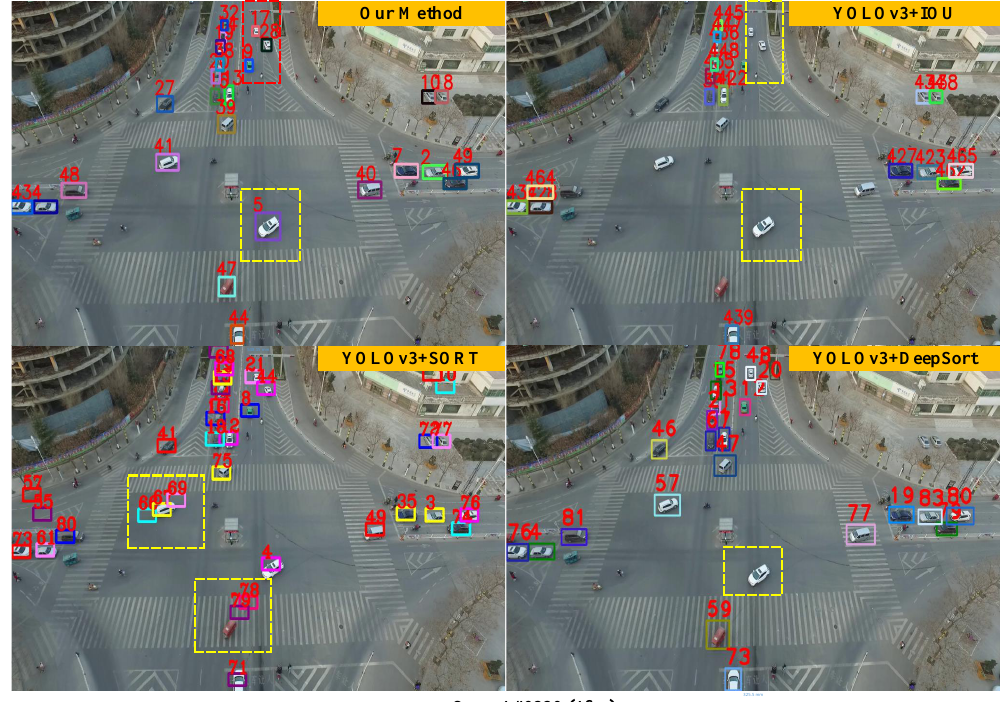
Figure 13. Tracking results of the four tracking algorithms in Scene 4 with frame rate of 5 fps, which are enlarged to show the tracking effect more clearly. Scene 4 is a crosroad, there are many vehicles in the scene, and the motion of the target is complicated. This set of results show that YOLOv3 + DeepSort easily lost the target when the target